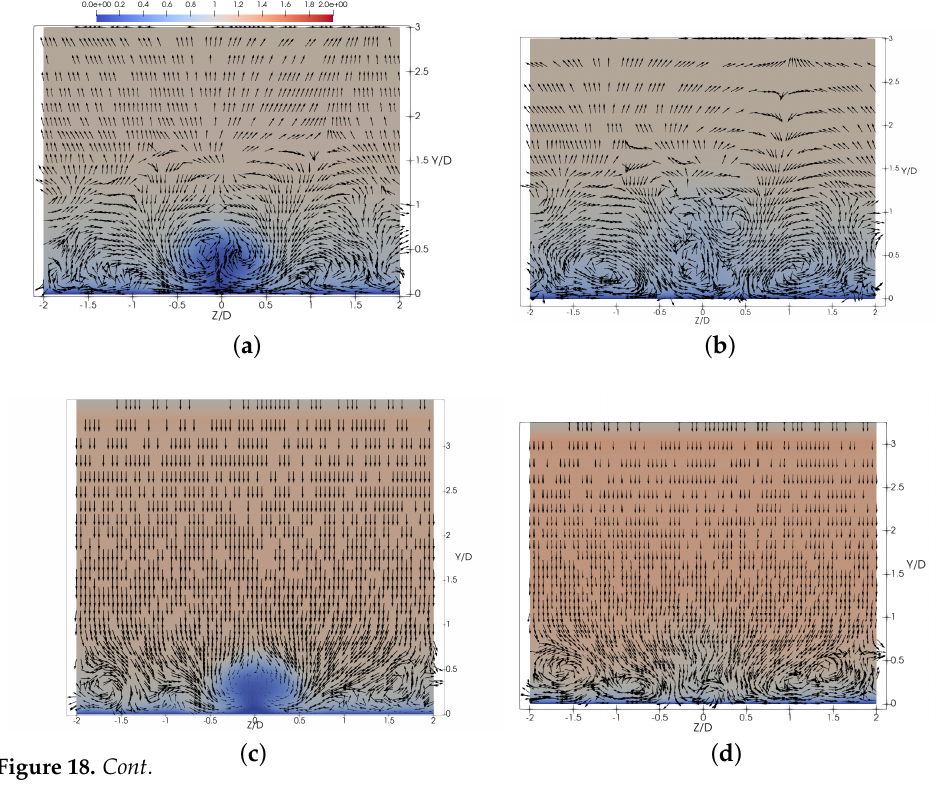
Figure 17. Visualization of coherent structures by means of Q -criterion iso-surfaces: ( a ) Case 1, ( b ) Case 2 and ( c ) Case 3 (colored by